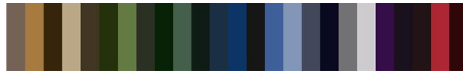
Figure 2: Color palette resulting from our adaptive database quan- tization (here in gray levels). The 25 clusters are represented by their barycenters in the color feature